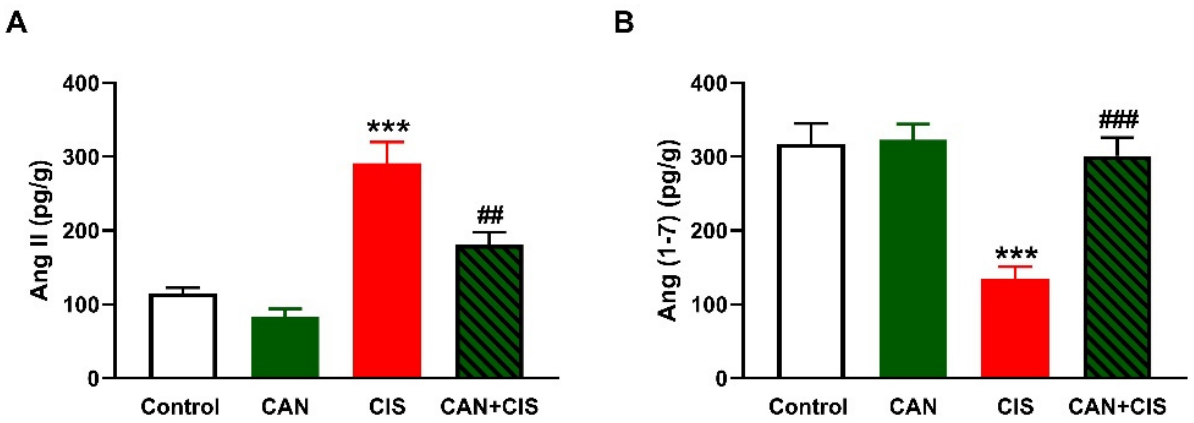
Figure 6. CAN decreased Ang II ( A ) and increased Ang (1–7) ( B ) in the lungs of CIS-administered rats. Data are Mean ± SEM, ( n = 8). *** p < 0.001 versus Control, and ## p < 0.01 and ### p < 0.001 versus CIS.